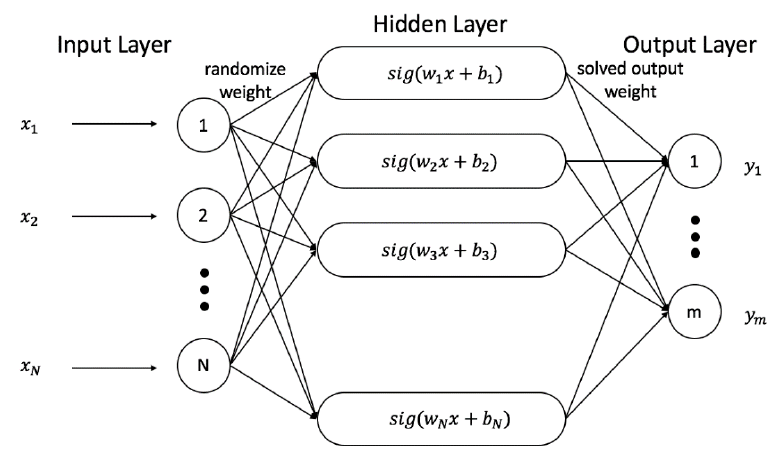
Figure 7. An example of ELM architecture [115].